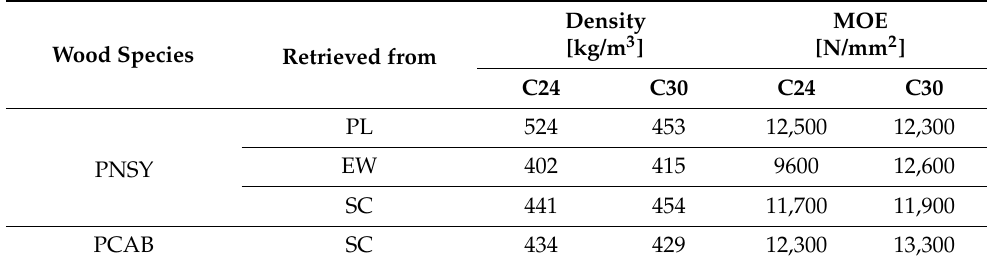
Table 4. Material data used in the analysis of numerical models of E–F version short frames made of glued material.